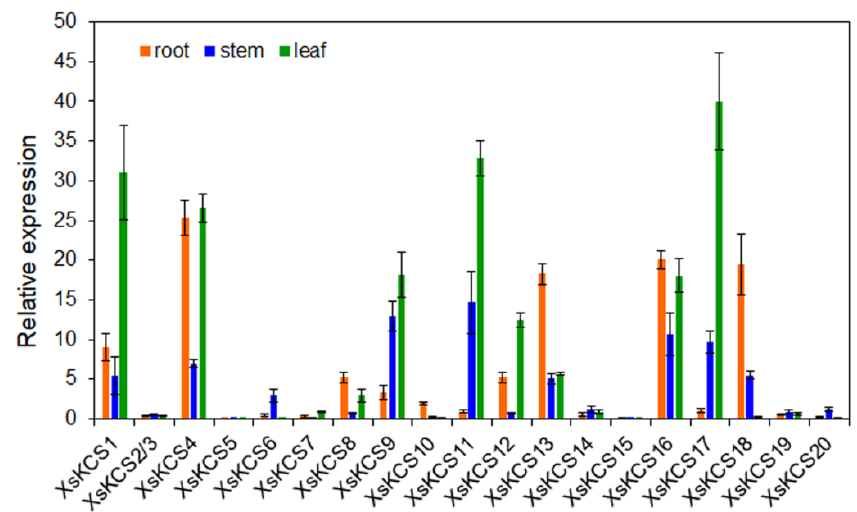
Figure 6. The expression profiles of XsKCS genes in different tissue. Error bars indicate SD.